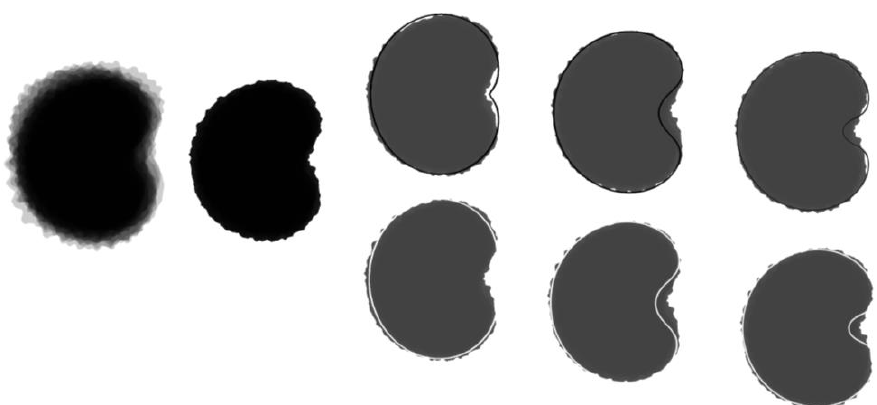
Figure 3. Method to obtain the J index in the average silhouette of Eudianthe coeli-rosa . From left to right: superimposed silhouettes of 20 seeds (lateral views); average silhouette; in 2 descending rows, left to right, average silhouette with models superimposed: LM4, LM3, and LM5, in black (above) and white (below). Area quantification with Image J in the compositions above (with the models in black) gives total area (T), while quantification in the compositions below (with the models in white) gives the values of the area shared by the average silhouette and the model (S). The J index is the ratio S/Tx100. The method is identical for individual seeds excluding the first step (obtention of the average silhouette).